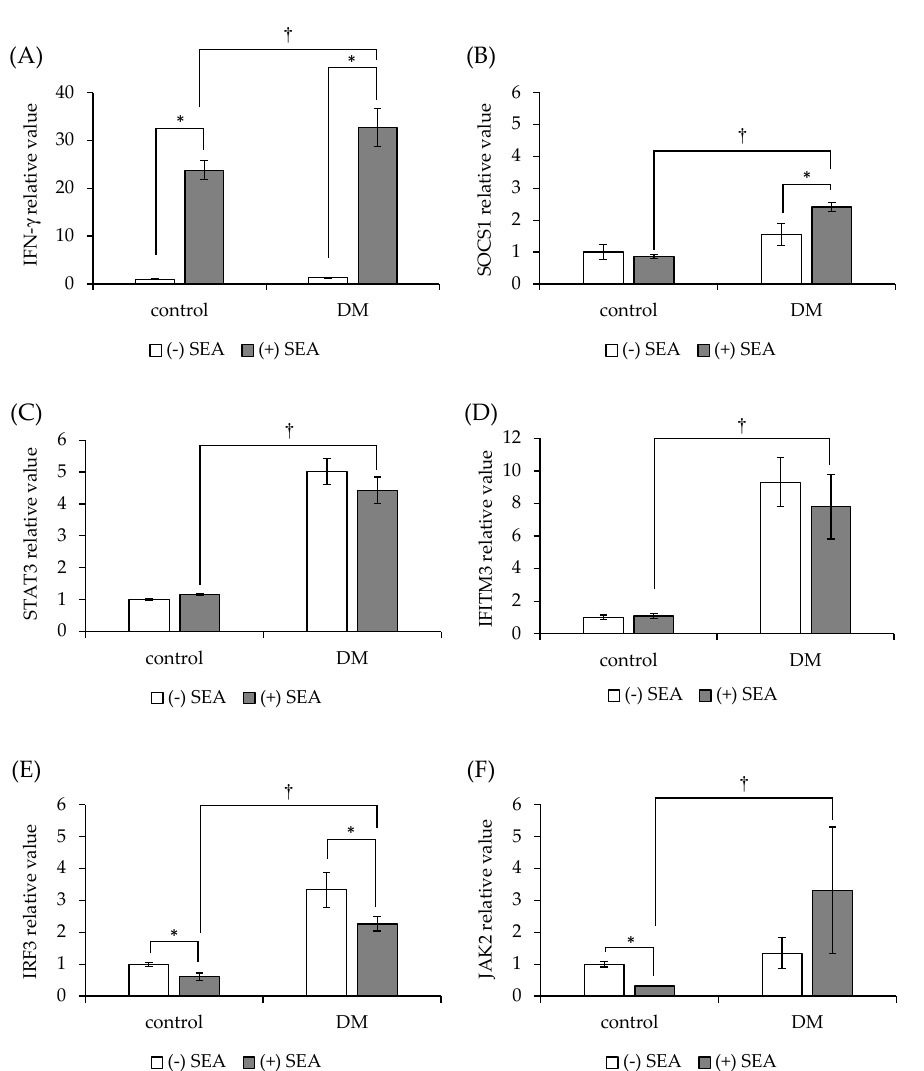
Figure 5. Comparison of SEA-induced JAK/STAT pathway-related gene expression in spleen cells from normal mice and diabetic mice (DM). ( A ) IFN- γ , ( B ) SOCS1, ( C ) STAT3, ( D ) IFITM3, ( E ) IRF3, ( F ) JAK2. Spleen cells from normal mice (control) and DM were exposed to SEA (50 ng/mL), and the expression of JAK/STAT pathway-related genes was examined by real-time RT-PCR. Gene expression was normalized to that of the Hprt gene. The fold change was determined relative to the control without SEA. * p < 0.05 compared to ( − ) SEA, † p < 0.05 compared to the control. The values represent the mean ± standard deviation of three independent experiments.